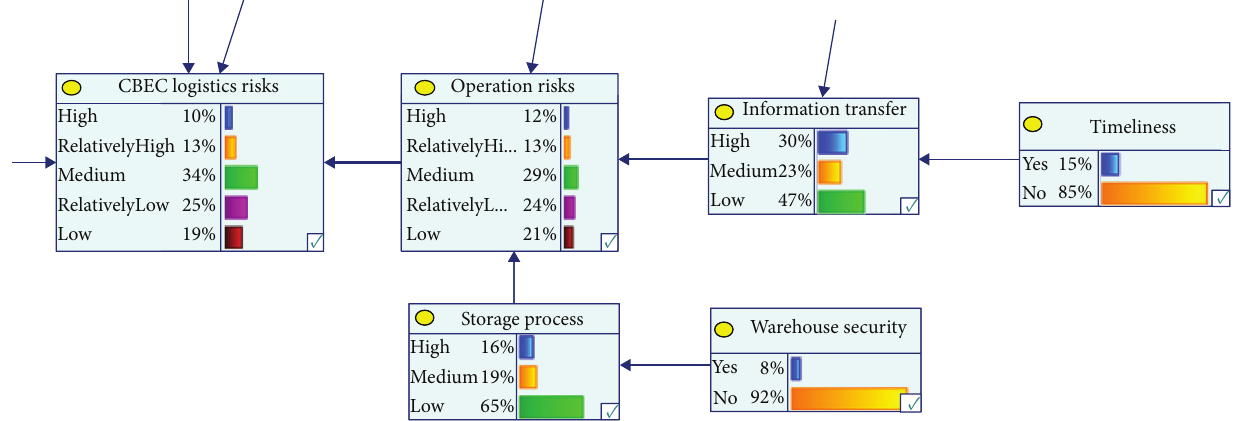
Figure 4: Before the operation